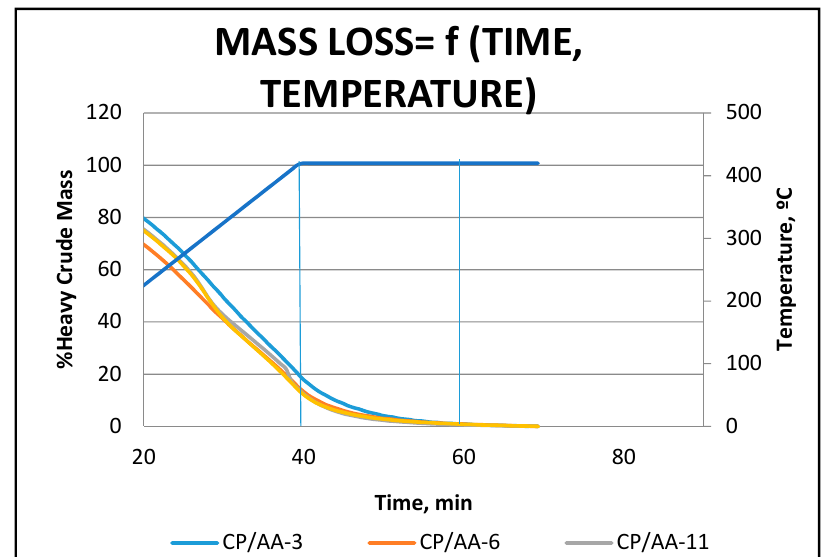
Figure 4. Thermogravimetric curves at 420 °C.